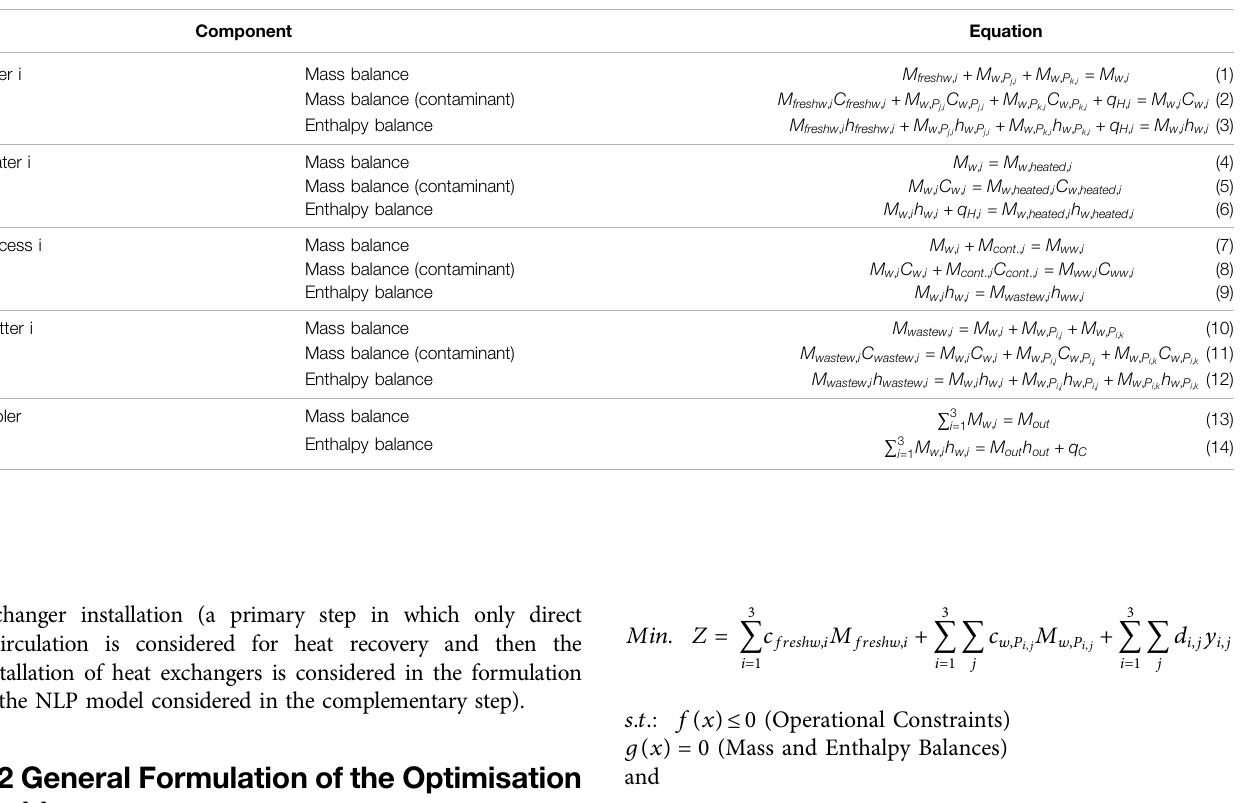
TABLE 6 | Mass and Enthalpy Balances for each component of the industrial